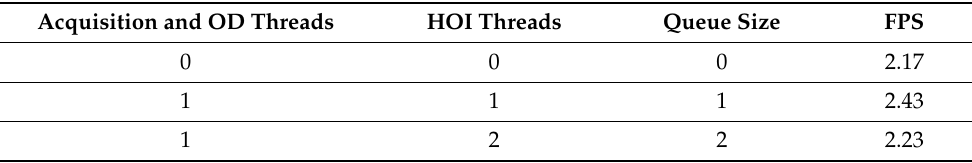
Table 7. HOI detection thread experiments.